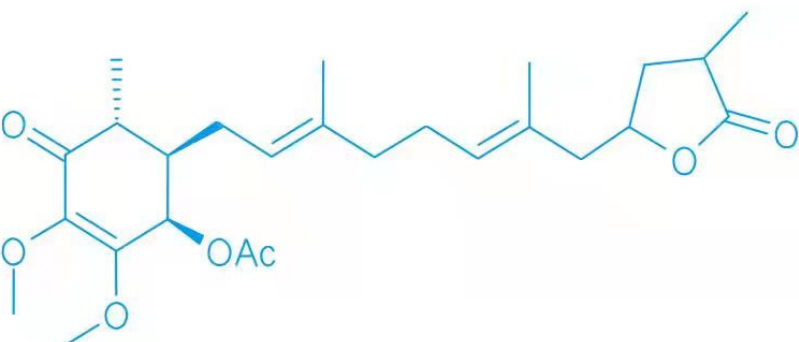
Figure 1. The chemical structure of 4-acetylarylquinolinol B.